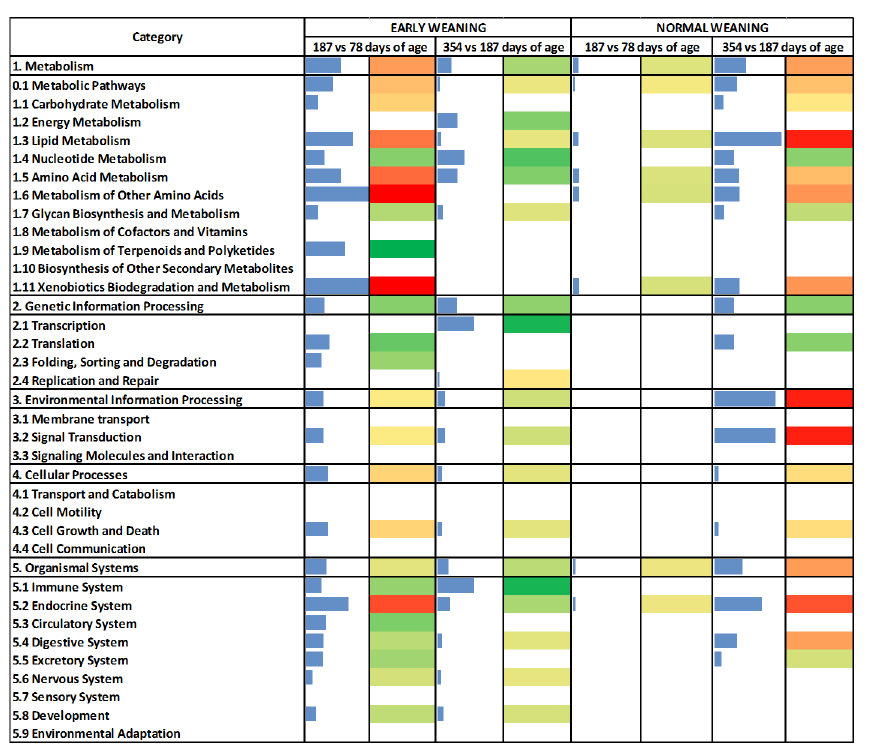
Fig 3. Dynamic Impact Approach (DIA) of differentially expressed genes (P value < 0.05; FDR < 0.10) on the Kyoto Encyclopedia of Genes and Genomes (KEGG) Pathways database. Flux represents the direction of each category and the corresponding subcategory (green color = inhibition, yellow color = stable, red color = activation with different color intensities according with the level of up-regulation or down- regulation). Blue bars denote the impact of each category and the corresponding subcategories.